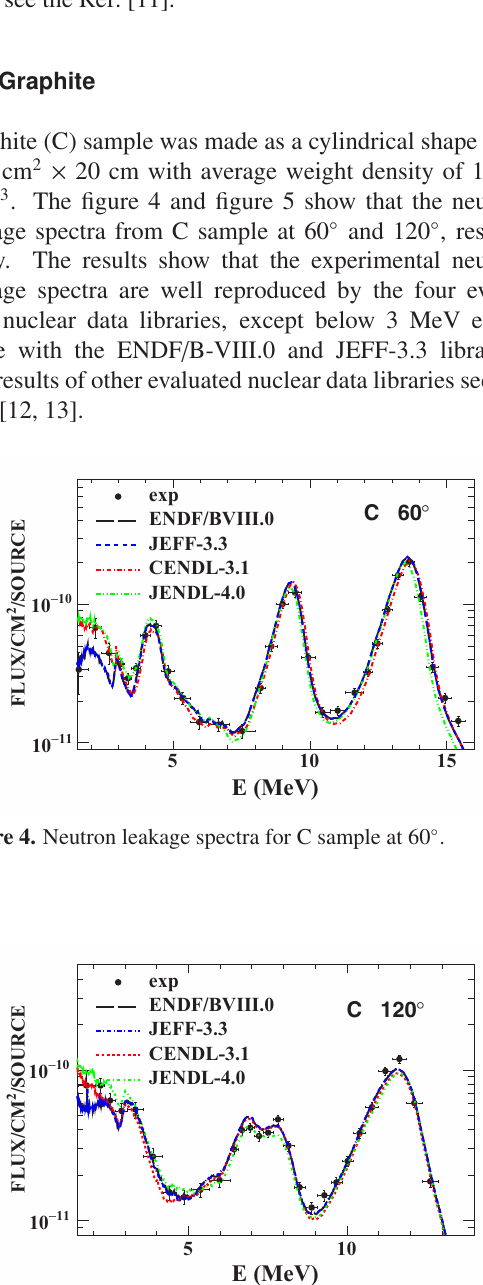
Figure 5. Neutron leakage spectra for C sample at 120 ◦